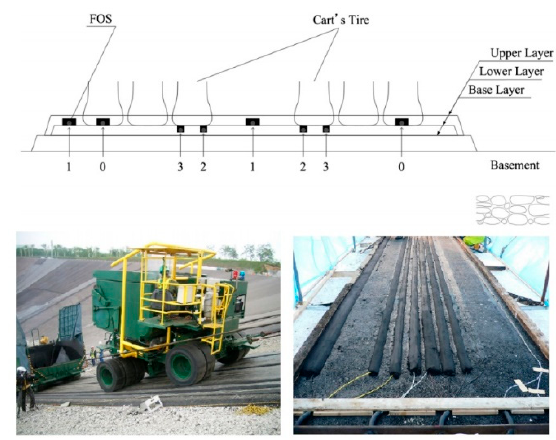
Figure 6. FOS installation on lower asphalt layer (figures are reproduced from Imai et al. [7]).